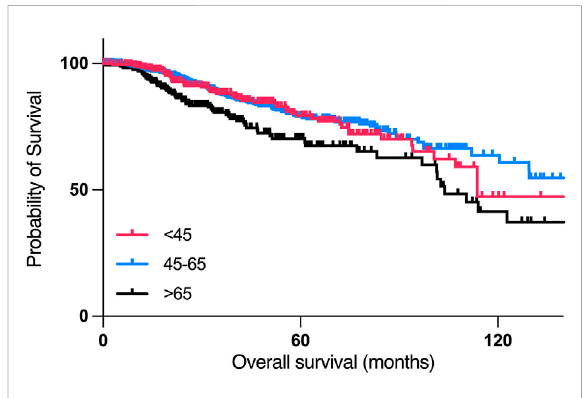
FIGURE 4 Overall survival analysis of women with breast cancer of different age groups.